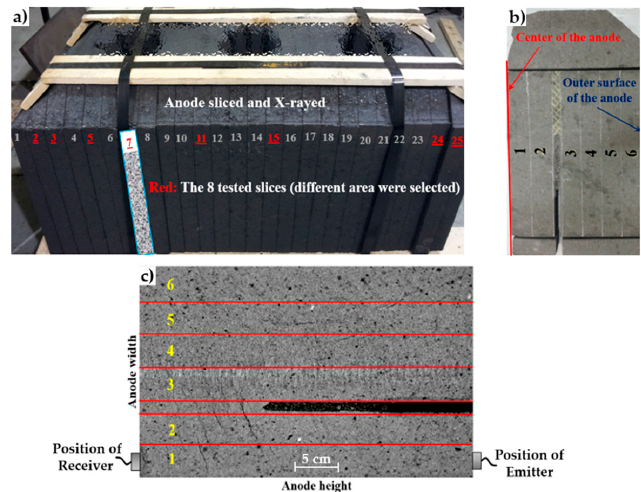
Figure 1. The sliced baked anode. ( a ) the selected 8 slices are identified in red; ( b ) example of a slice used for acousto-ultrasonic testing; ( c ) example X-ray image obtained for slice 7. The corridors are identified by the red lines and numbered from 1–6. The black region corresponds to one of the anode slots. Adapted from [6].